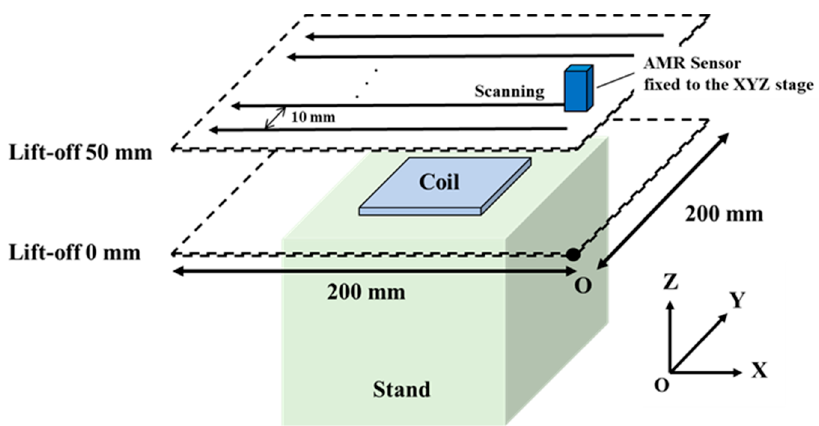
Figure 4. Schematic of magnetic field distribution measurement.